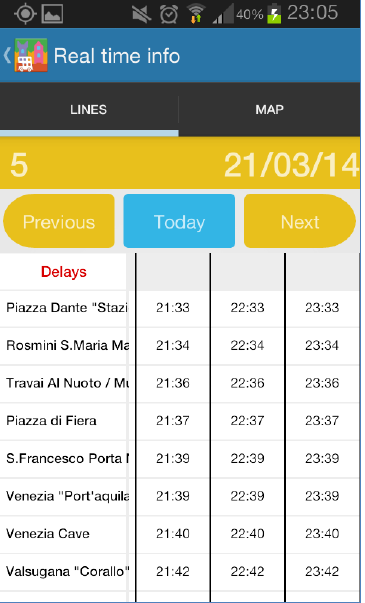
Figure 7. Timetables of local